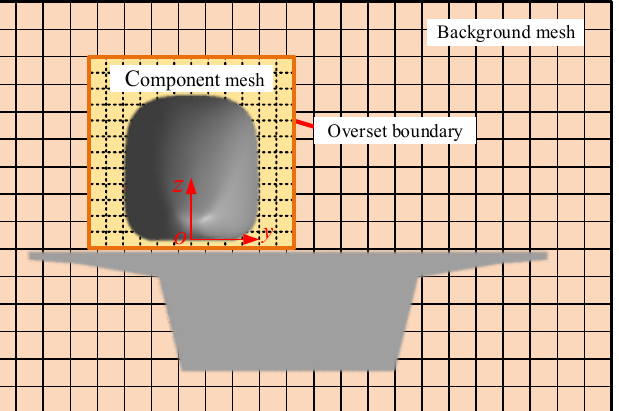
Figure 3. Overview of overset mesh.